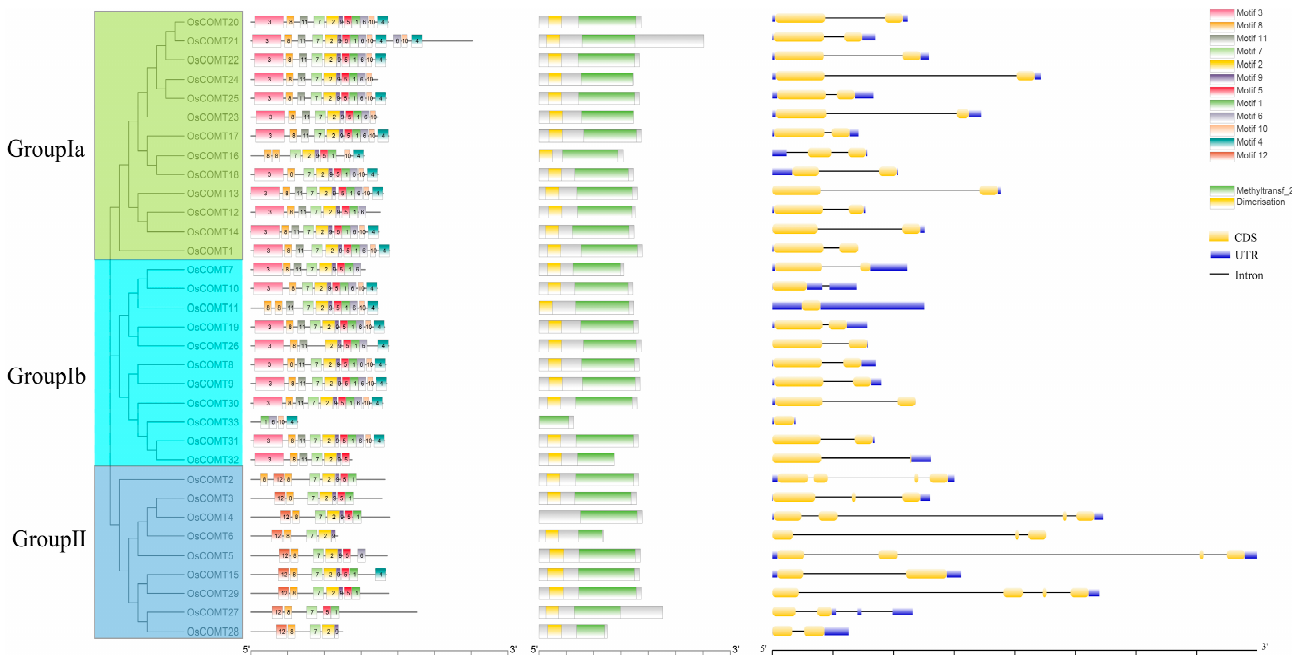
Figure 4. Domain motif and gene structure of OsCOMTs . Different colors were used to represent different domain motifs. The yellow round-corner rectangle represents CDS, the blue rectangle represents UTR, and the black line represents introns.